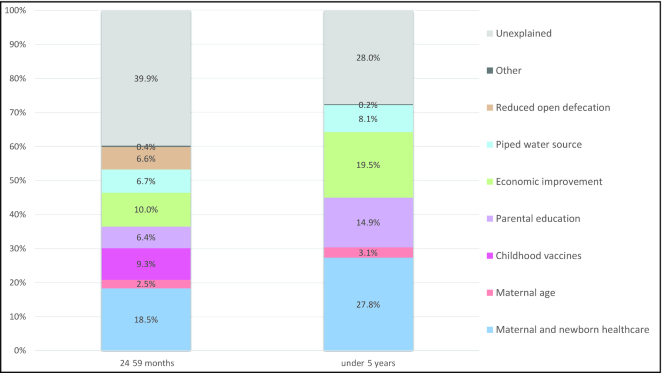
Decomposing predicted changes in HAZ (i.e., percentage contribution of determinant domains) for children <5 y old from 1992/93–2017. *The 6–23-mo age category results are not presented due to the model results being unstable and only explaining 0.21 SD decline in HAZ and the <6-mo old group due to small sample sizes. *Indicators included maternal and newborn healthcare (SBA and ANC ≥4), parental education (maternal and paternal education), reduced open defecation, maternal age (adolescent pregnancy, <18 years of age), economic improvement (wealth index), childhood vaccines (DPT3 vaccine), and piped water source. *Other category includes child age, gender, and region for all age groups in addition to reduction in household crowding (0.4%) for the 24–49-mo old age group. *Parental education breakdown: children 24–59 mo: maternal: 4.0%, paternal: 2.4%; and children <5 y old : maternal: 7.5%, paternal: 7.4%. ANC, antenatal care; DPT3, diphtheria, pertussis, and tetanus; HAZ, height-for-age z score; SBA, skilled birth attendant.